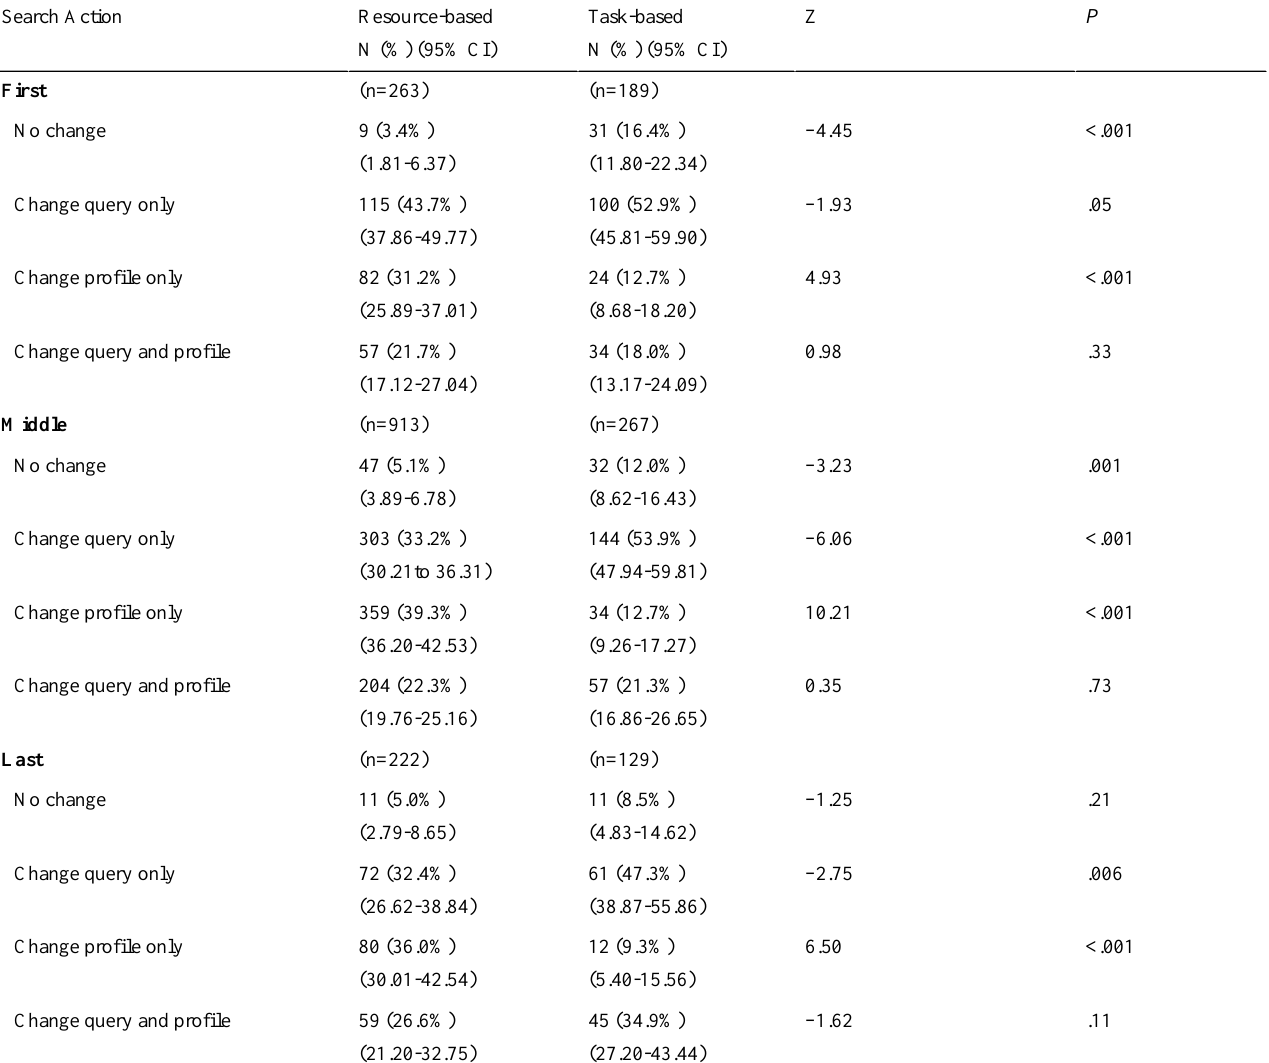
Table 6. Search action between resource-based and task-based systems during a session